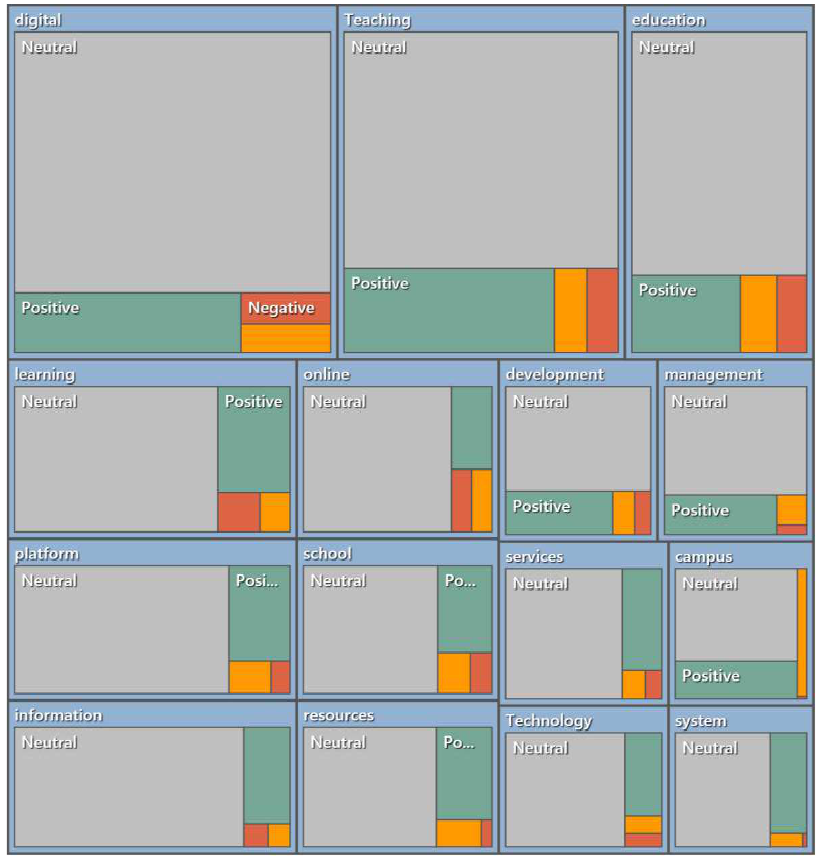
Figure 3. Coding hierarchy of students’ attitudes towards digitalization in